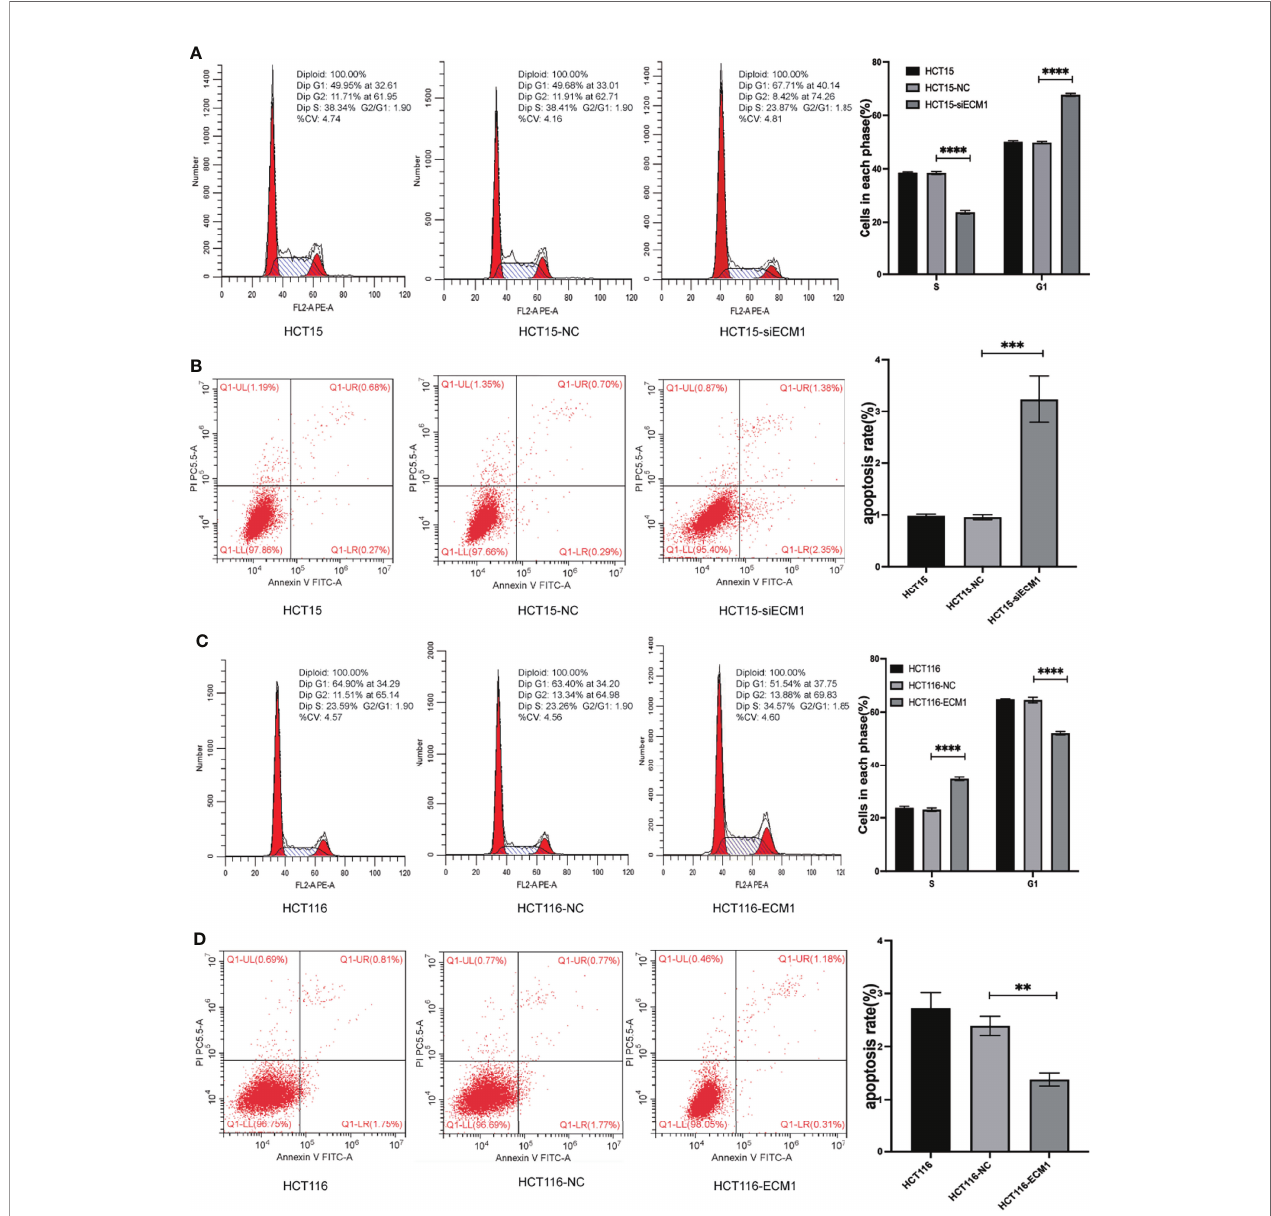
FIGURE 3 | ECM1 regulates the progression of the cell cycle and apoptotic death in CRC cells. Following ECM1 knockdown or overexpression, apoptosis and cell cycle progression were analyzed via fl ow cytometry. (A, B) Changes in the progression of the cell cycle and apoptotic cell death following the knockdown of ECM1. (C, D) Changes in the progression of the cell cycle and apoptotic cell death following ECM1 overexpression. Data are means ± SD (**P < 0.01, ***P < 0.001, ****P <